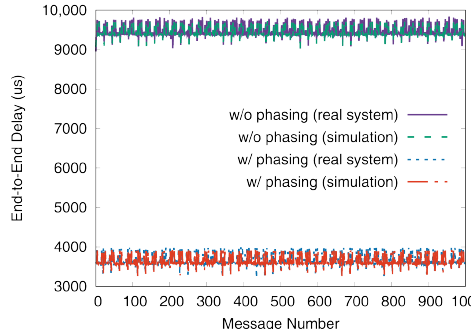
Figure 13. D e 2 e distribution of VC 0 in test set 0.